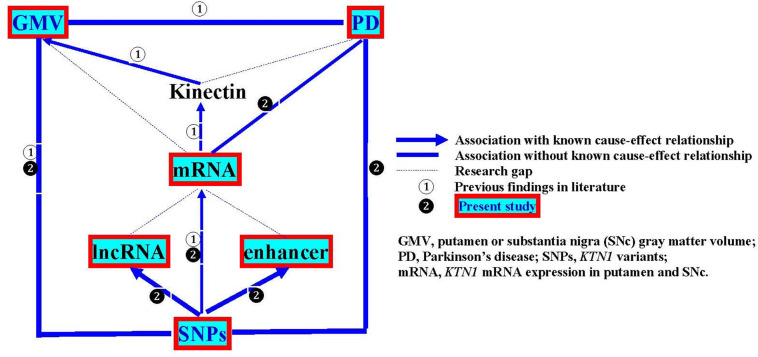
Regulatory pathway from genotypes to phenotypes.